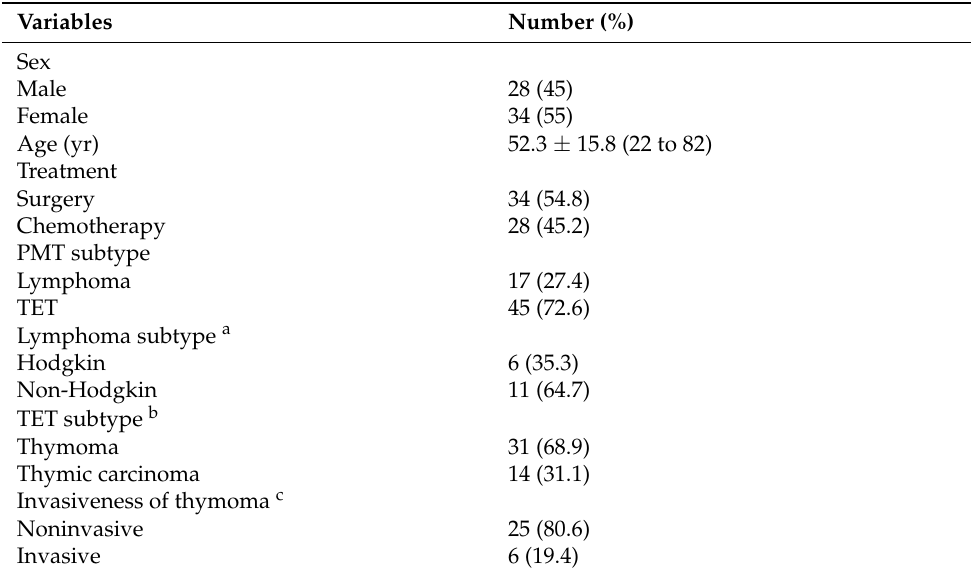
Table 1. Demographic and clinical characteristics of 62 patients with